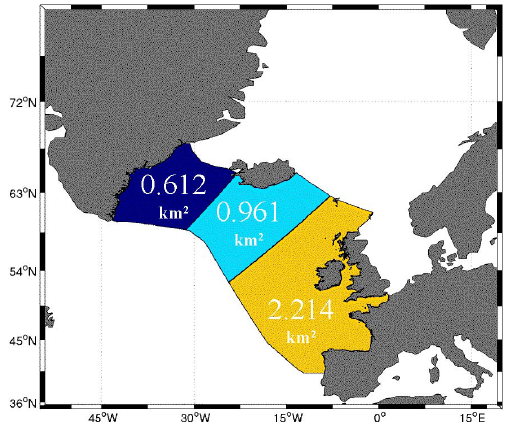
Fig. 4. Areas (in 10 6 km 2 ) of the Irminger (dark blue), Iceland (indigo blue) and ENA (yellow) basins enclosed by the “OVIDE box”. These areas were used in the calculation of C ant storage rates from the specific inventory estimates in Fig. 3. The northern geo- graphical boundaries of the “OVIDE box” are defined by the North Atlantic sills east and west from Iceland (according to the ETOPO2 bathymethry), while the southern one is delimited by the tracks of the OVIDE